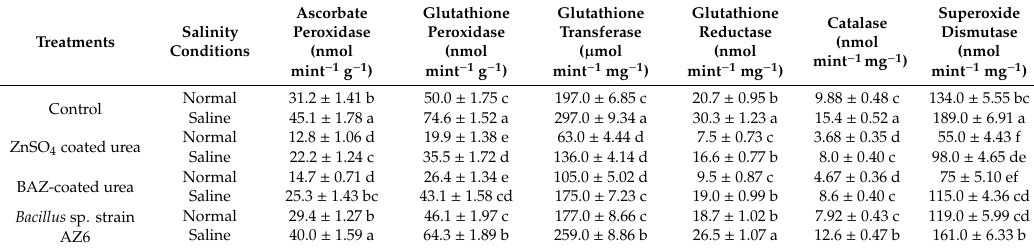
Table 3. The impact of BAZ ( Bacillus augmented ZnO)-coated urea on antioxidant enzyme activity of wheat under salinity